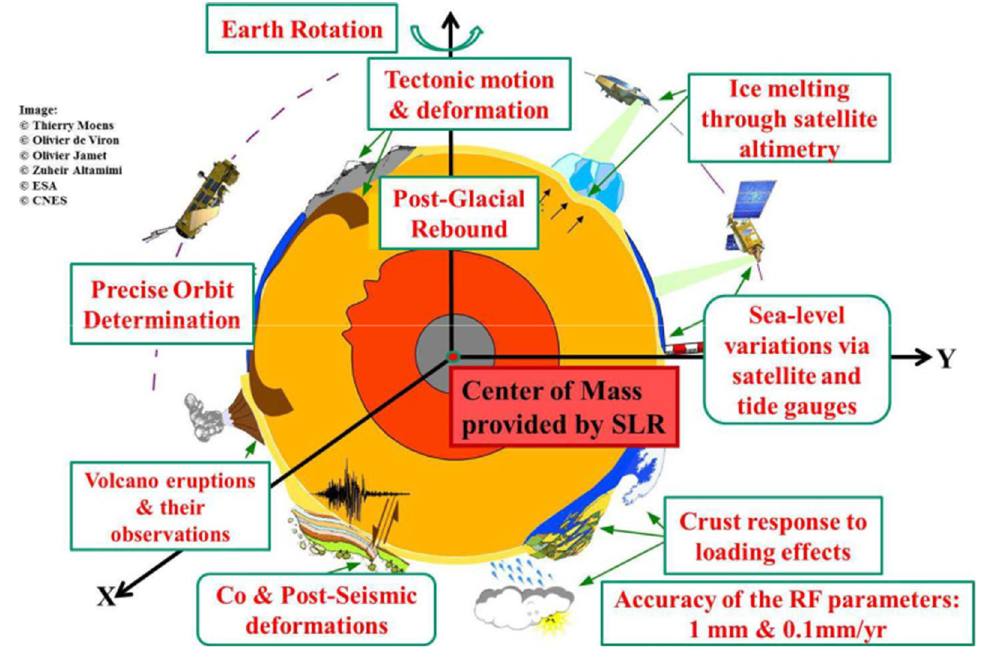
Fig. 1 The GENESIS mission’s primary goal is a significant improvement of the International Terrestrial Reference Frame (ITRF). The ITRF is recognized to be the metrological foundation for all space‑ and ground‑based observations in Earth Science and Navigation, and therefore this mission will potentially have a major impact in a large number of GNSS and Earth Observation